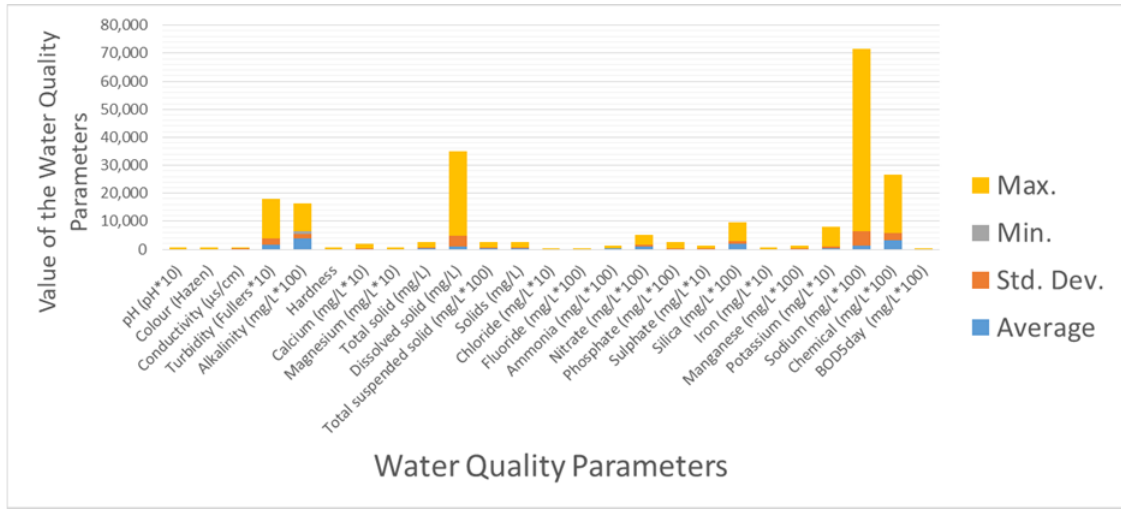
Figure 1. The statistical analysis of the water quality parameters of Langat River.